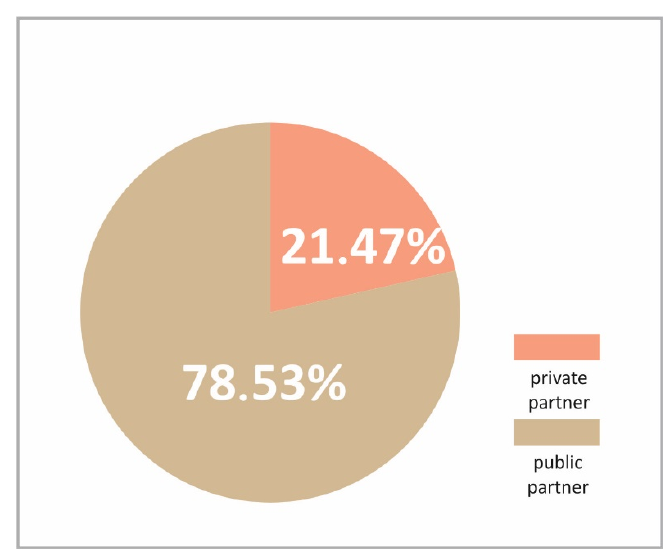
Figure 5. Structure of promotional instruments in the EEN in 2017–2018 for entire Europe, including the type of leading partner.